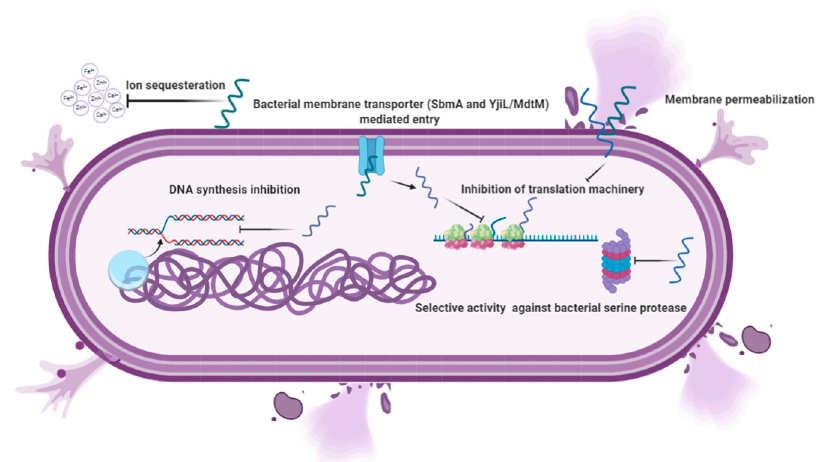
Figure 2. Different mechanisms are used by cathelicidins and β -defensins to eliminate the invading pathogens. After entry, the amphipathic peptides use secondary mechanisms such as inhibition of replication, translation, and sequestration of ions. In addition to membrane lytic action, an attack on these vital processes is life-threatening to bacterial cells and ultimately results in the demise of the cell.